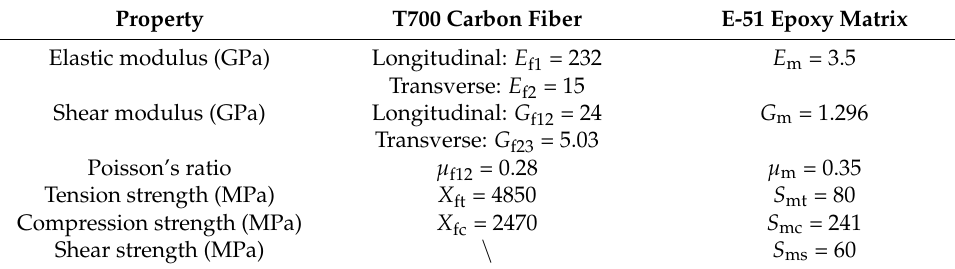
Table 1. Mechanical properties of component